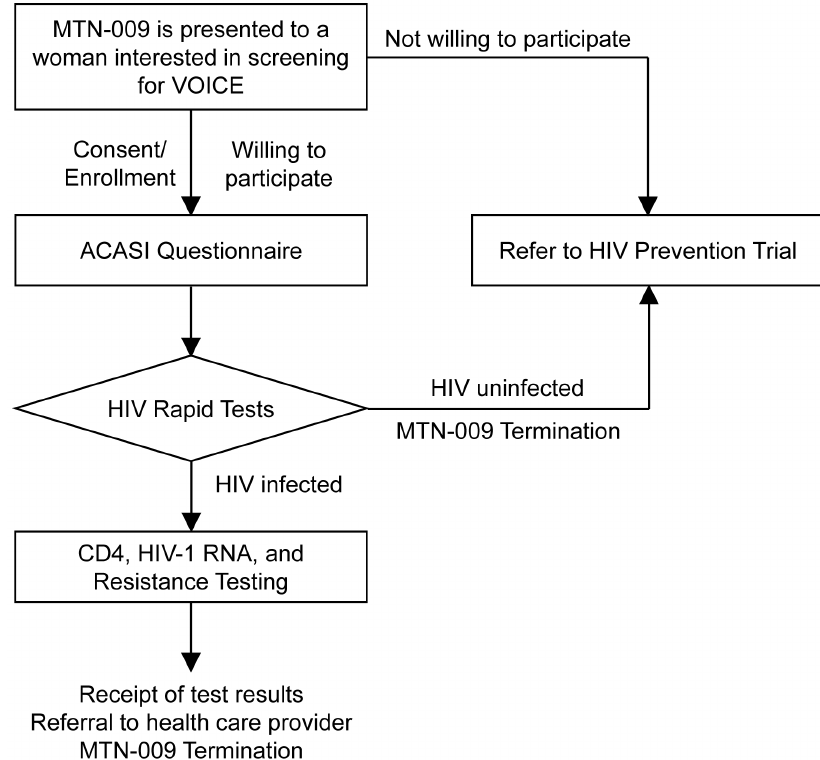
Figure 1. MTN-009 Study Schema.